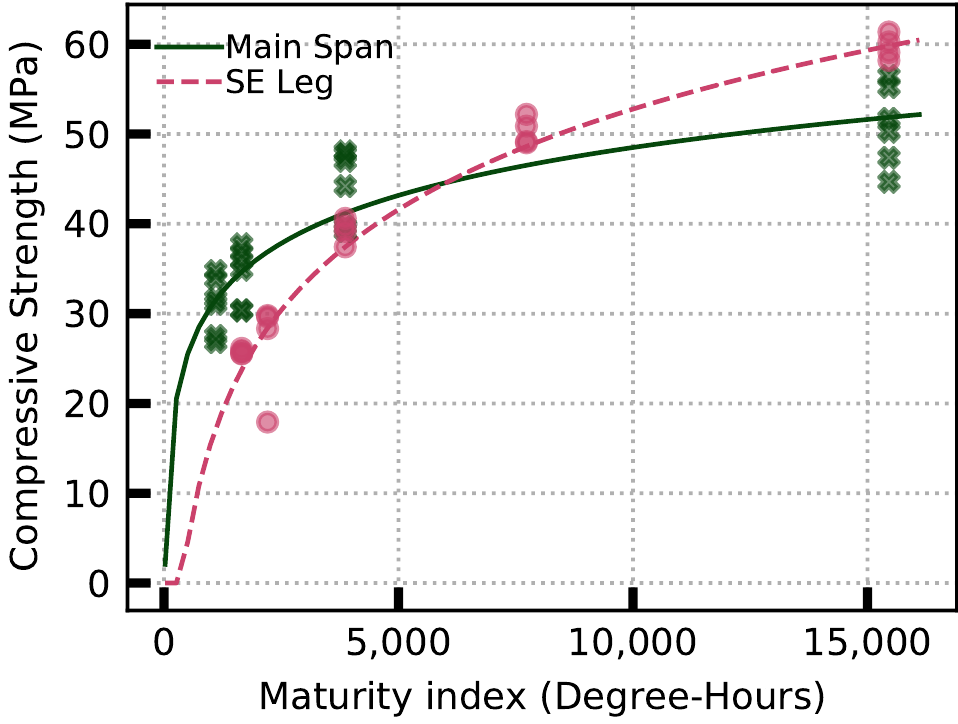
Figure 10. Compressive strength obtained as a function of maturity index based on the initial concrete core sample tests. Based on the logarithmic fit for the cylinder data for Streicker bridge, the constants, C 1 and C 2 , are obtained for the main span/northeast leg (MS/NE) and southeast leg (SE) and shown in Table 2. Table 2. Constants of the maturity index and compressive strength logarithmic fit.